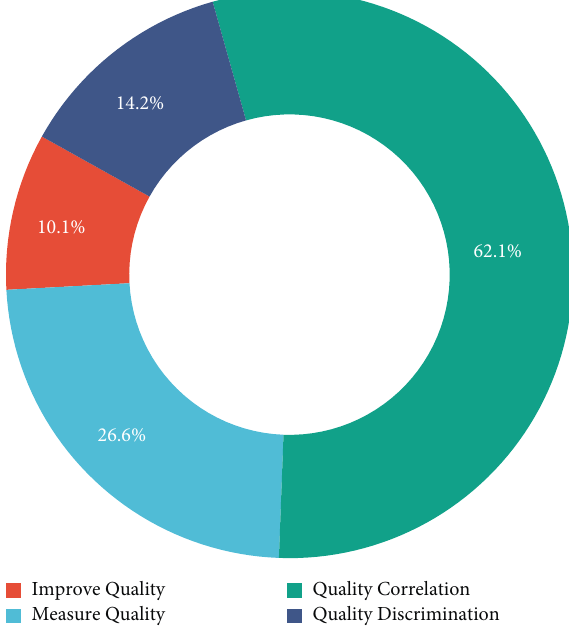
Figure 4: Percentage of the articles classified by coffee quality objective. The RQ3 led to the formation of the quality objective